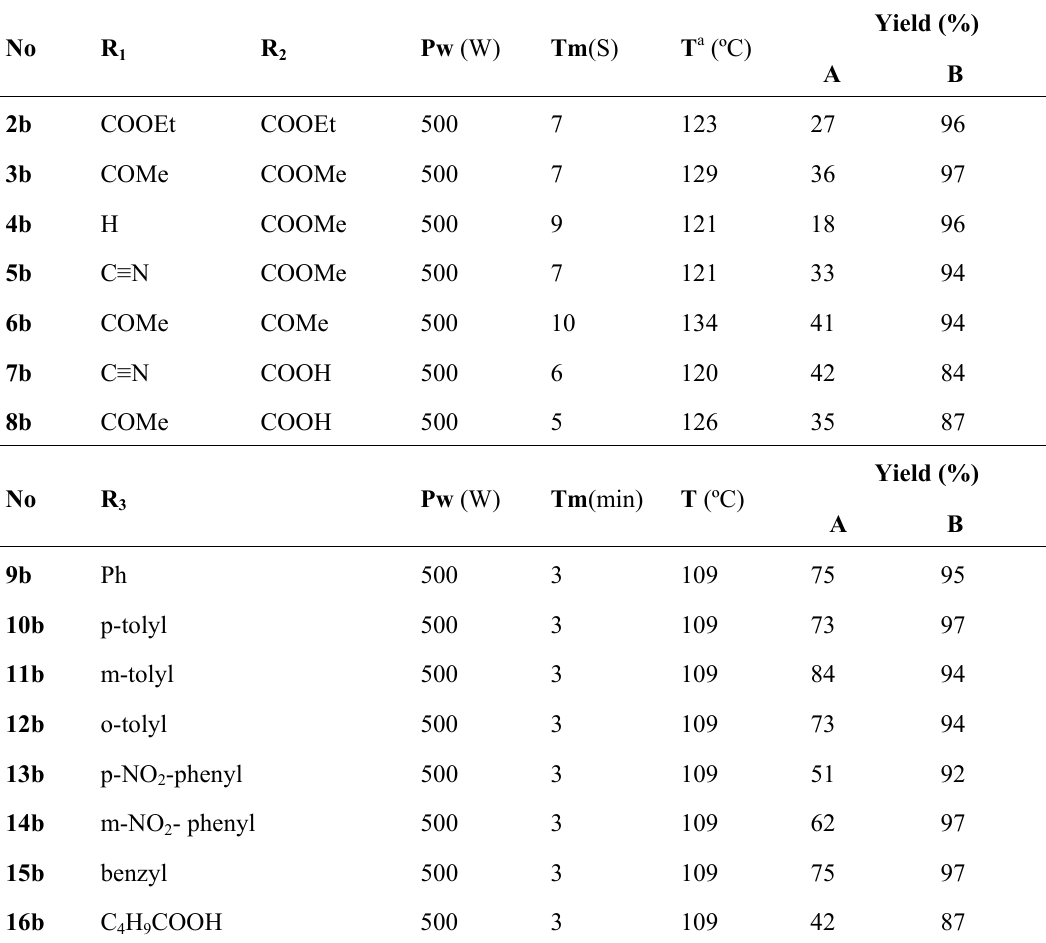
Table 1. Reaction conditions, substituents and yields of obtained compounds 2b - 8b